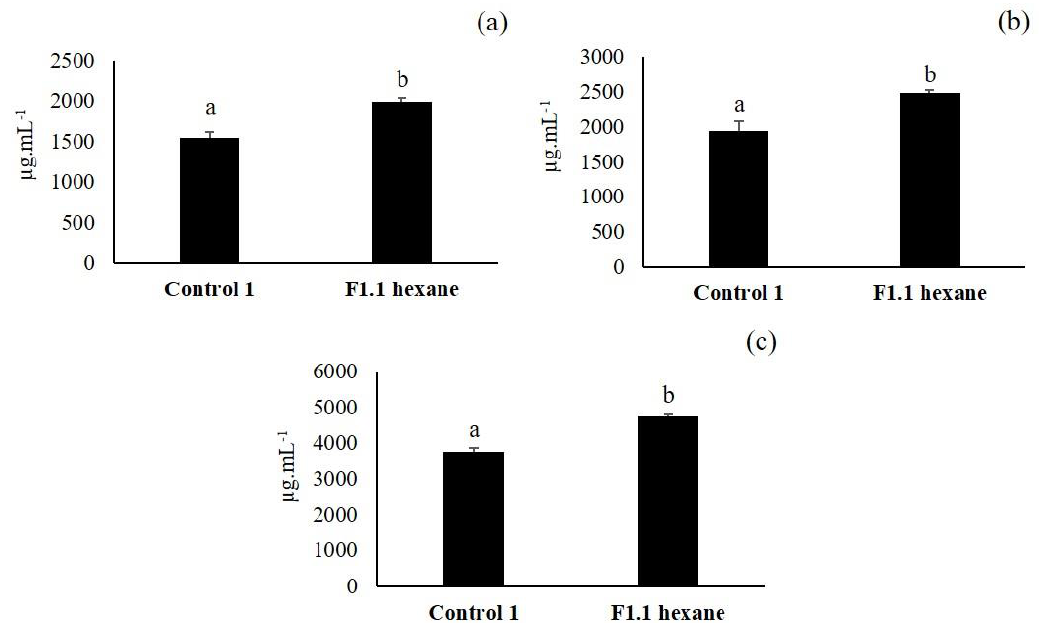
Figure 6. Daidzin ( a ), genistin ( b ) and malonyl genistin ( c ) production in the seeds inoculated with F1.1 obtained from the second VLC and in control 1 seeds. The amount of isoflavones is expressed in µ g · mL − 1 ( n = 30 soybean seeds × 3 replicates). Di ff erent letters show significant statistical di ff erences between treatments in each isoflavone ( p < 0.05). Error bars correspond to standard deviation (SD).